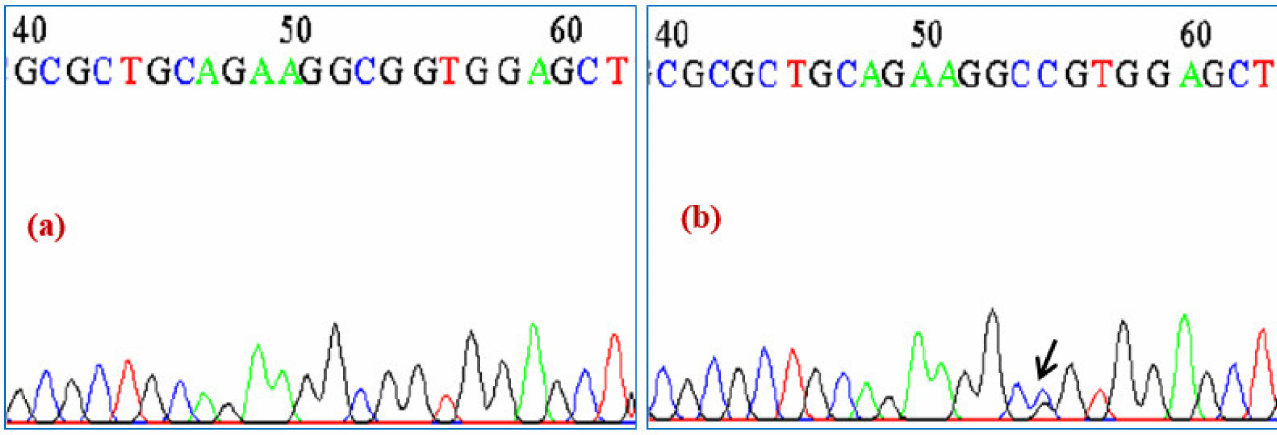
Figure 3. ( a , b ) The chromatogram of exon 2 of NKX2-5 gene showing sequence variation GCG > GCC. ( a ) Wild type sequence. ( b ) Mutant